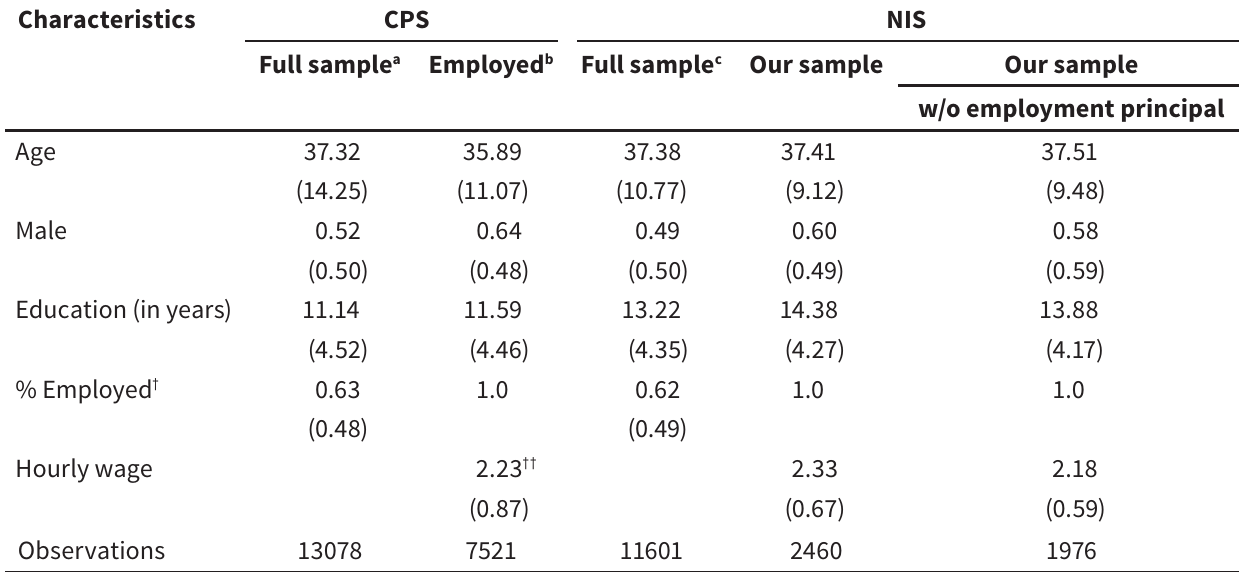
Table 1 Sample comparisons between 2003 CPS noncitizen respondents and NIS respondents